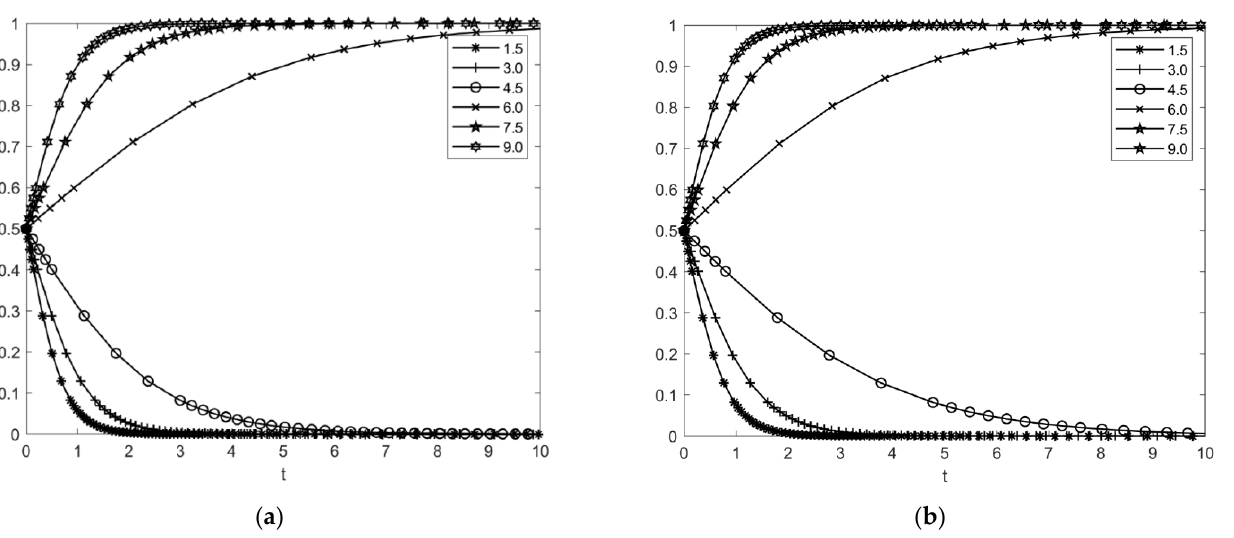
Figure 9. The effect of 2𝑎 + 𝐸 on the cooperation strategy of enterprises 1 and 2. ( a ) enterprise 1; ( b ) enterprise 2.